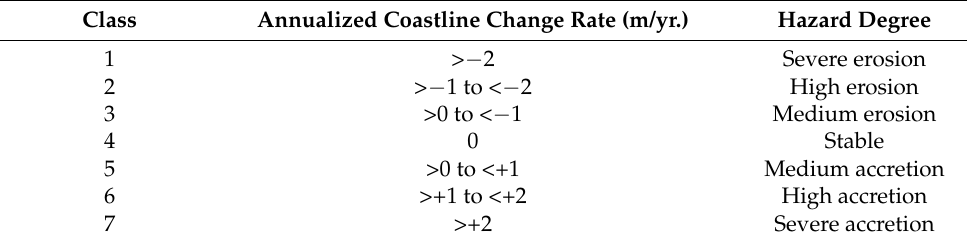
Table 3. Hazard degree of coastline change rate. Class Annualized Coastline Change Rate